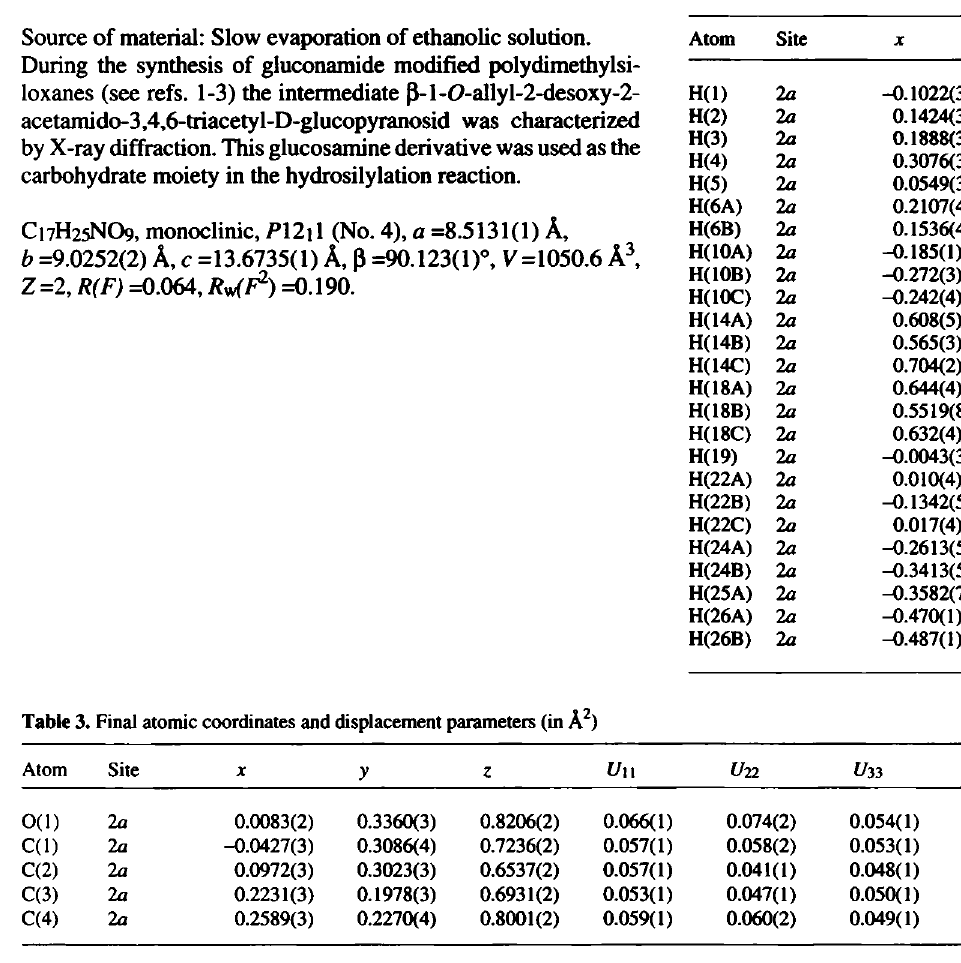
Table 1. Parameters used for the X-ray data collection Crystal: EHffiractometer: Enraf-Nonius CAD4 Scan mode: